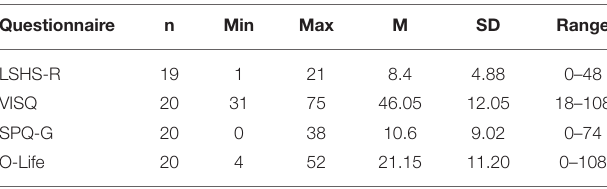
TABLE 2 | Results in the questionnaires assessing the predisposition to schizotypal traits and hallucinatory experiences.